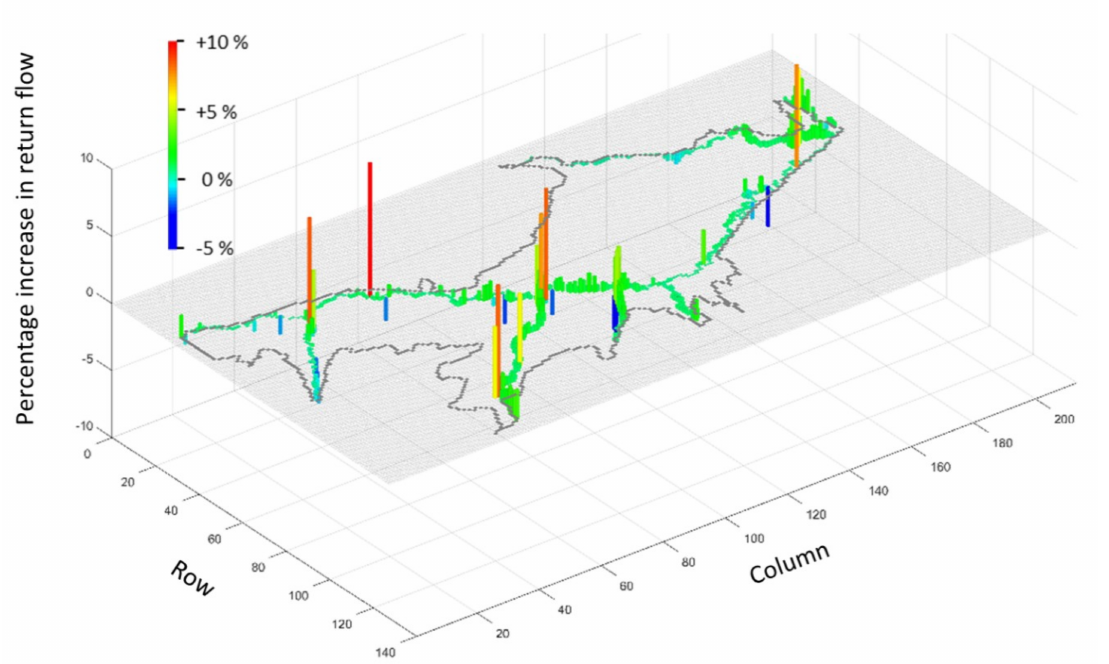
Figure 16. Percentage increase of return flow between reduced irrigation scenario and baseline